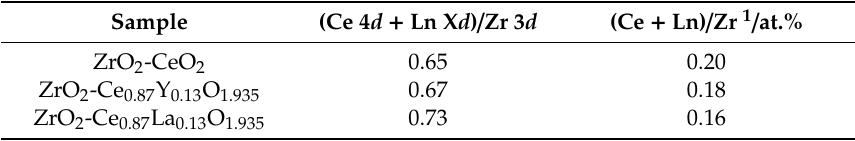
Table 4. XPS quantitative results for the undoped and Ln-doped ZrO 2 -CeO 2 samples, subjected to a reduction treatment in H 2 (5%) / Ar at 900 ◦ C for 1